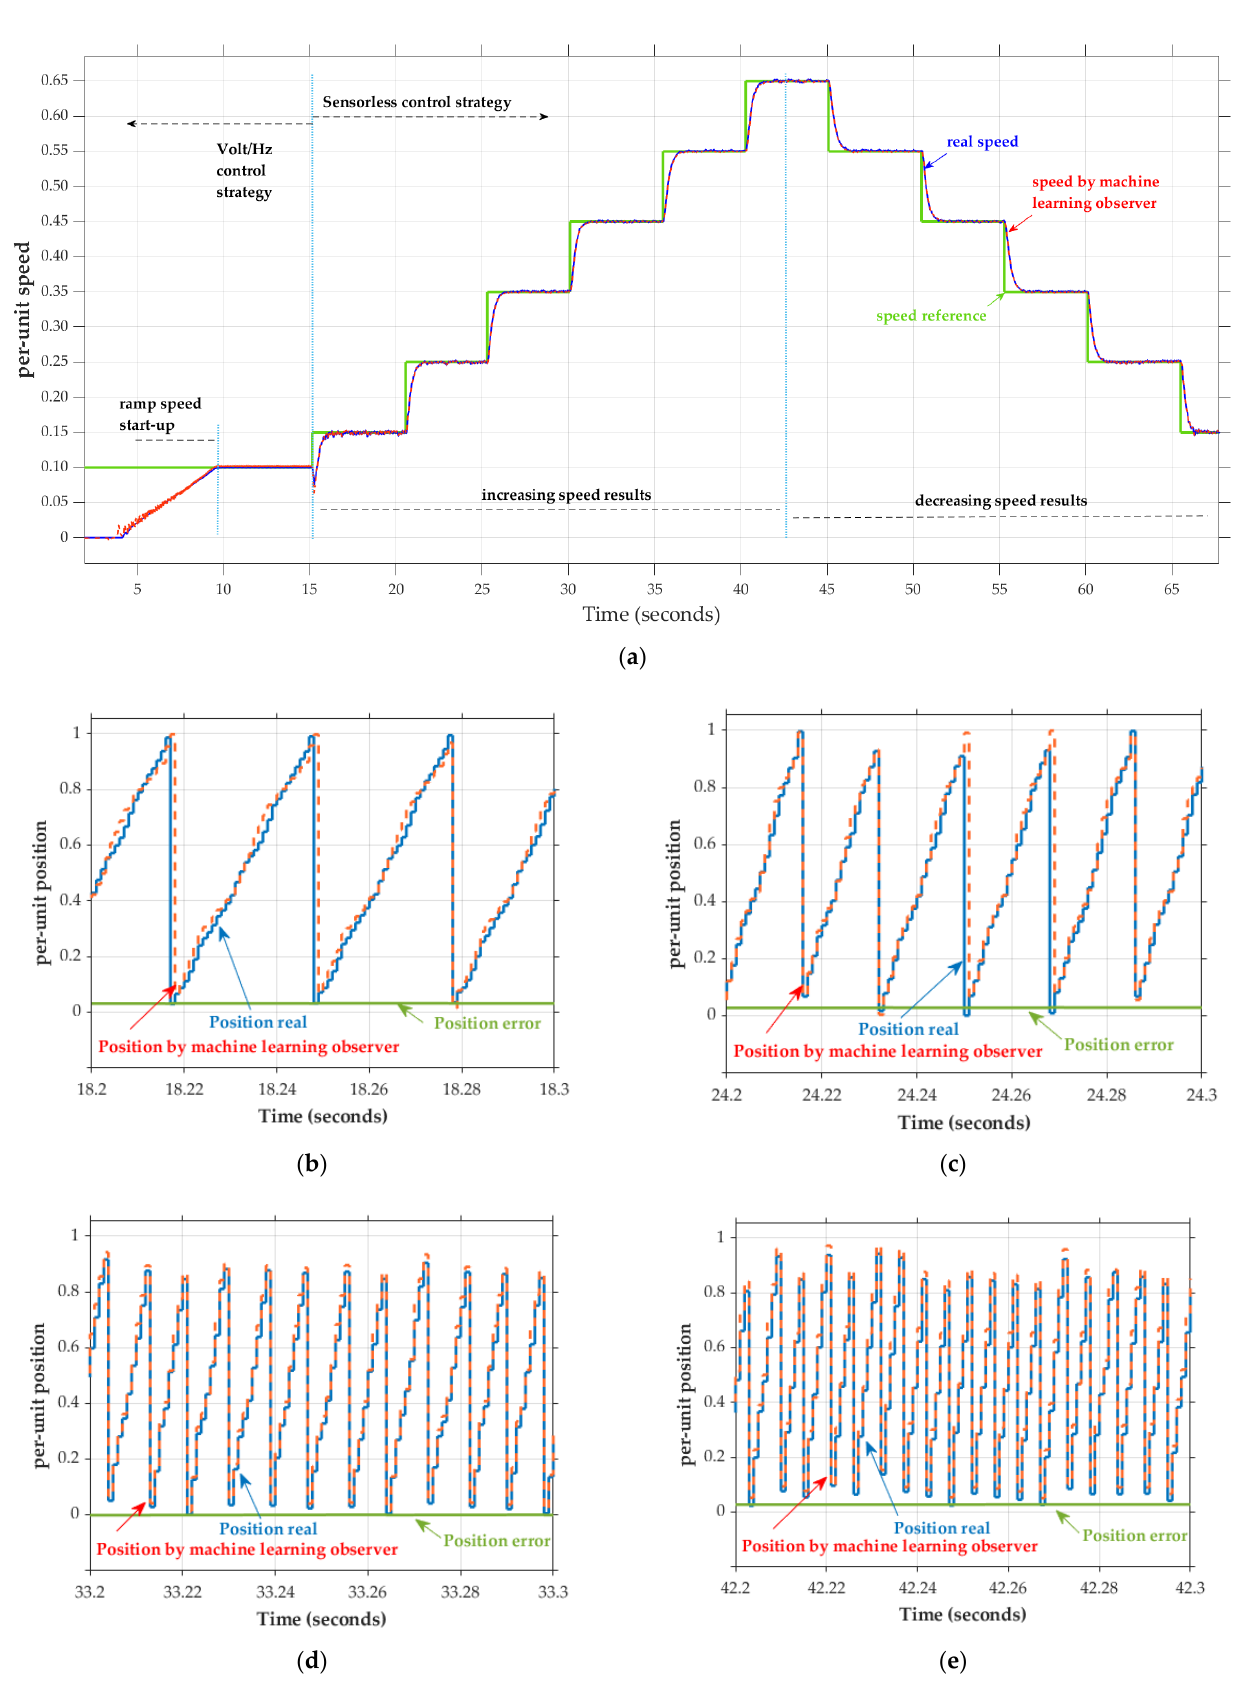
Figure 16. Experimental results for ( a ) rotor speed responses and for rotor positions at ( b ) 0.15, ( c ) 0.25, ( d ) 0.45, and ( e ) 0.65